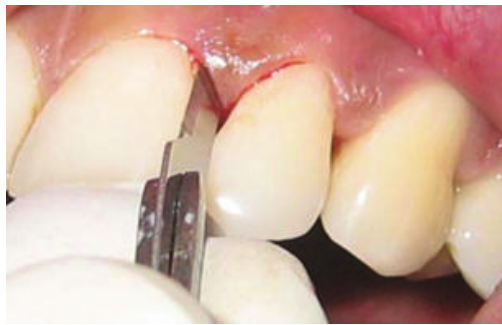
Figure 7: Intrasulcular